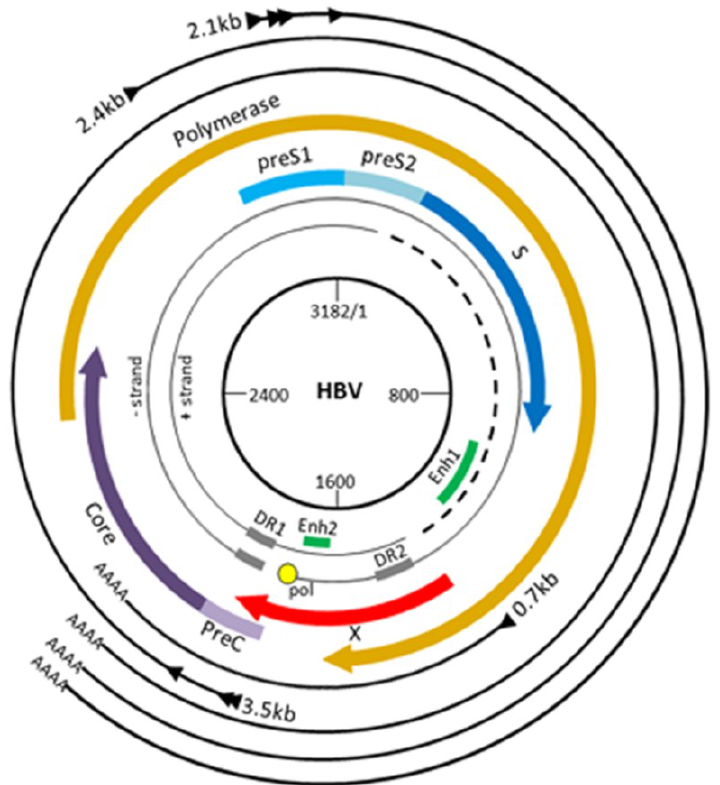
Figure 2. HBV genome organization. HBV contains a small, partially double-stranded (~dsDNA) genome (see inner black circles) that consists of a full-length negative strand and an incomplete (dashed lines) positive strand. The genome contains four promoters, two enhancer regions (Enh1, Enh2), and two direct repeats (DR1, DR2). The four ORFs are depicted by the colored arrows. During virus replication, the ~dsDNA genome is repaired into covalently closed circular (ccc) DNA, which serves as the template for viral transcription. The four major transcripts, shown as thin black outer arrows, are described in the text. Note that the X ORF (red) is present in all four HBV